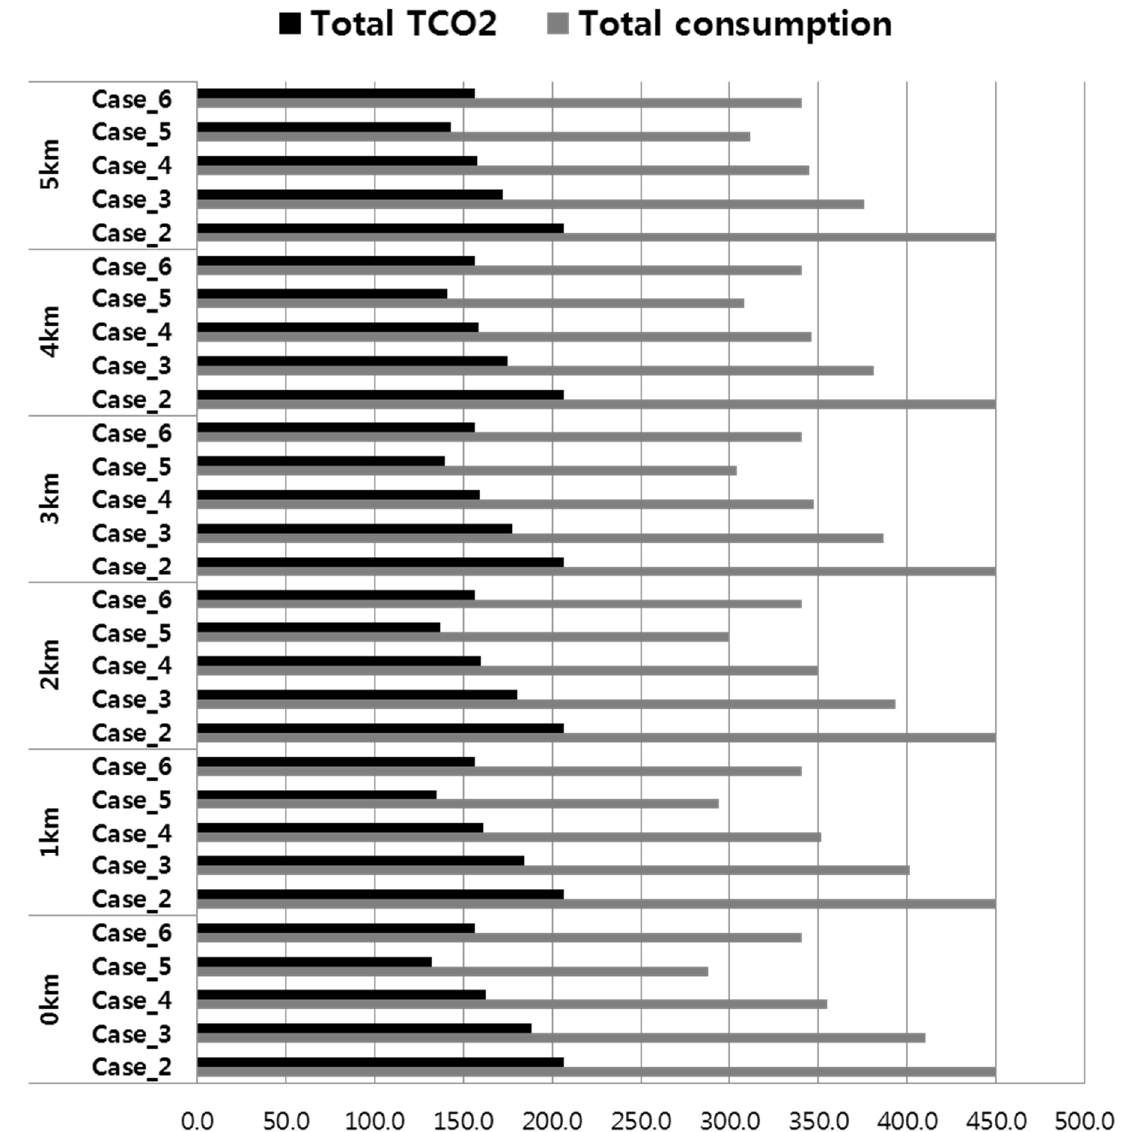
Figure 7. CO 2 Emission of Heat Pump as a function of pipe network distance from the heat